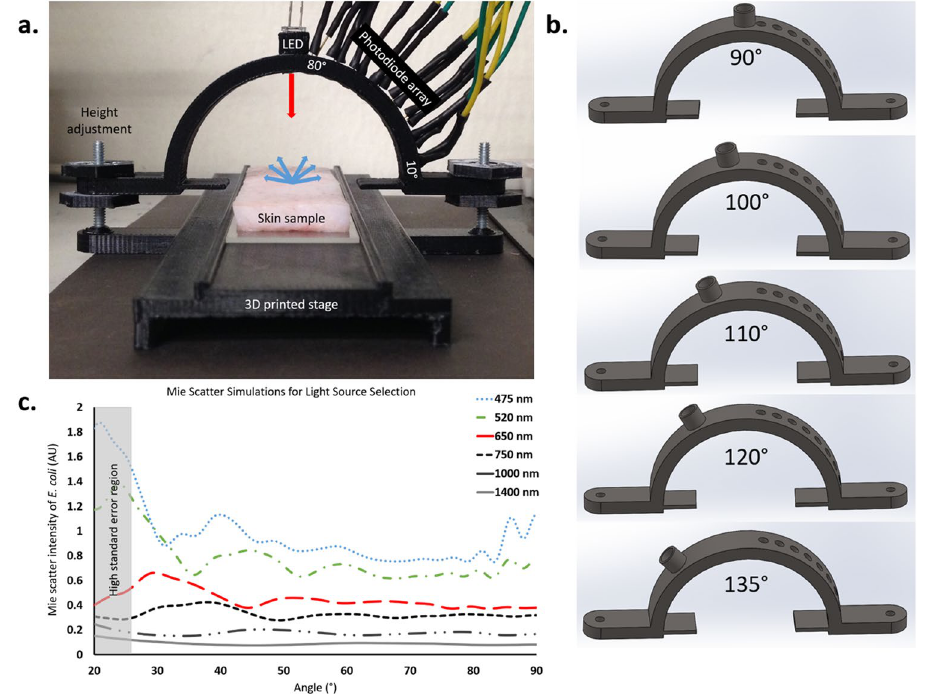
Figure 3. Device design. ( a ) The complete photodiode array used for data collection. The array is height adjustable to ensure analysis at the surface of each individual sample. A 650 nm LED illuminates the sample and Mie scatter spectra are detected by photodiodes at increments of 10° from 10° to 80° relative to the tissue surface. The incident angle of the LED is adjustable through individual attachments, due to space constraints on this miniaturized device. ( b ) Each of the five attachments used to change the incident light angle. All five attachments have identical sizes and photodiode locations, with the only difference being the angle at which the LED is held. Using these attachments, the incident light angle can be changed between 90°, 100°, 110°, 120°, and 135°. ( c ) Mie scatter simulations used to determine the optimal wavelength to use for the light source within this device. Simulations were conducted based off of parameters for E. coli and specifications of the device designed. Based on these simulations, a 650 nm light source was selected as the optimal incident